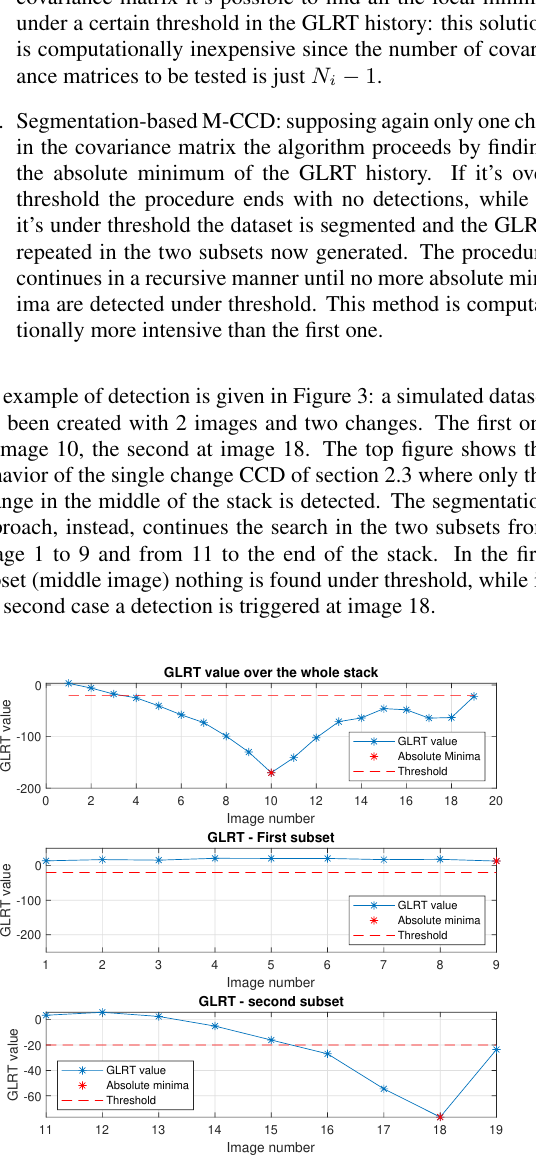
Figure 3: An example of detection: In the top image the only triggered detection is the one at image 10. The middle and bottom figures are the two subsets generated after the segmentation. In the first subset nothing is found, in the second one a change is found at image